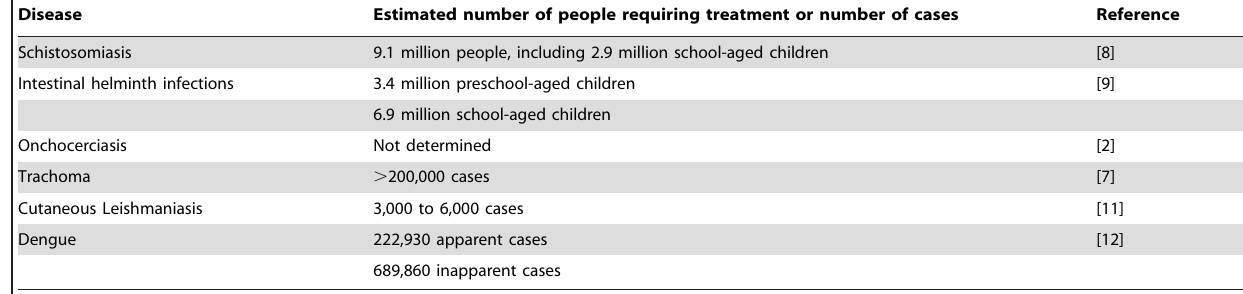
Disease Estimated number of people requiring treatment or number of cases